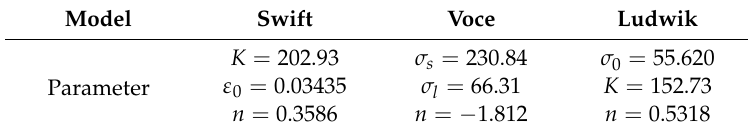
Figure 7. The entire stress-plastic strain curve fitted by classical hardening laws. Table 2. Parameter values for each constitutive models.